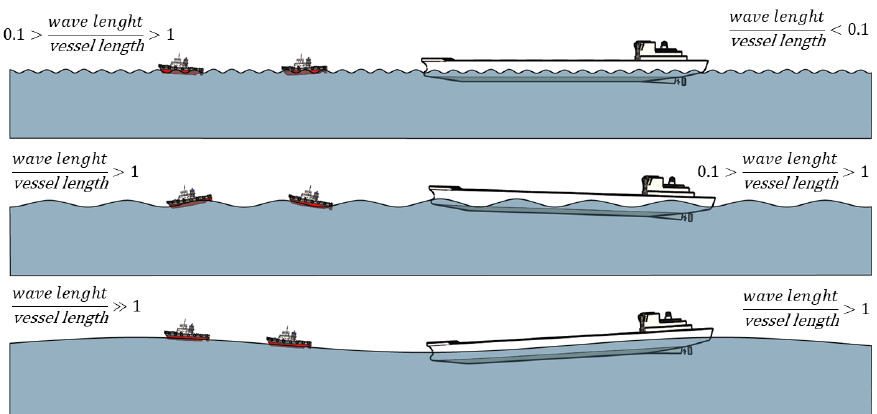
Figure 3. Influence of wave period on ship movements for different types of vessels and the same wave height. Adapted from Molina (2015) [27].